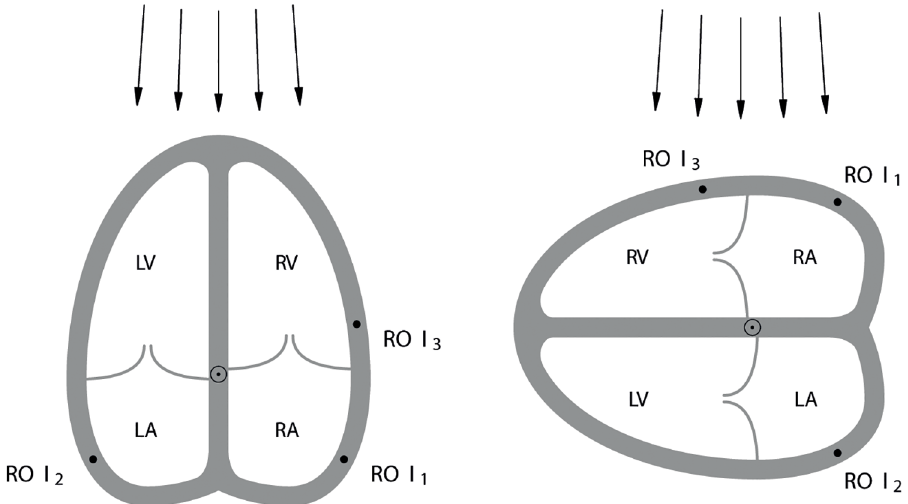
Fig 1. Schema of a longitudinal (left) and a transverse (right) four chamber view of the heart, showing ROI placement in the right atrium ( ROI 1 ), left atrium ( ROI 2 ), and right ventricle (reference ROI; ROI 3 ). Since in the longitudinal view the ultrasound beam is directed apico-basally, atrial structures are distant and atrial lateral walls are met tangentially. In the transverse view the ultrasound beam meets the lateral atrial walls perpendicularly. ROI, region of interest; RA, right atrium, LA, left atrium; RV, right ventricle; LV, left